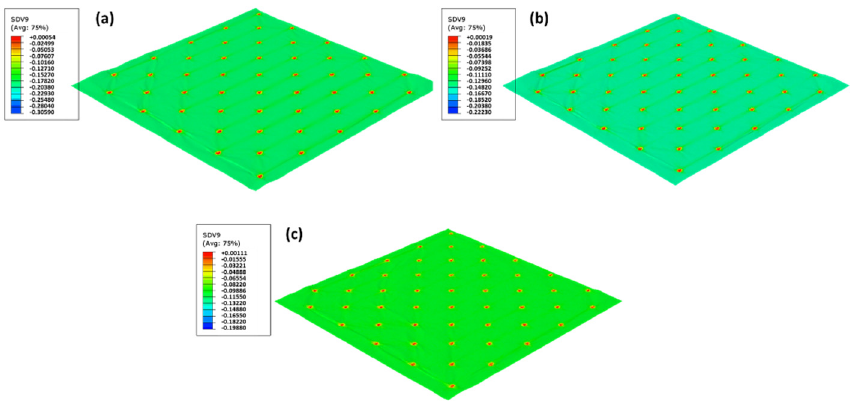
Figure 12. The yield function for micro die for different pressures: ( a ) 2.4 bar, ( b ) 2.8 bar, and ( c ) 3.2 bar.